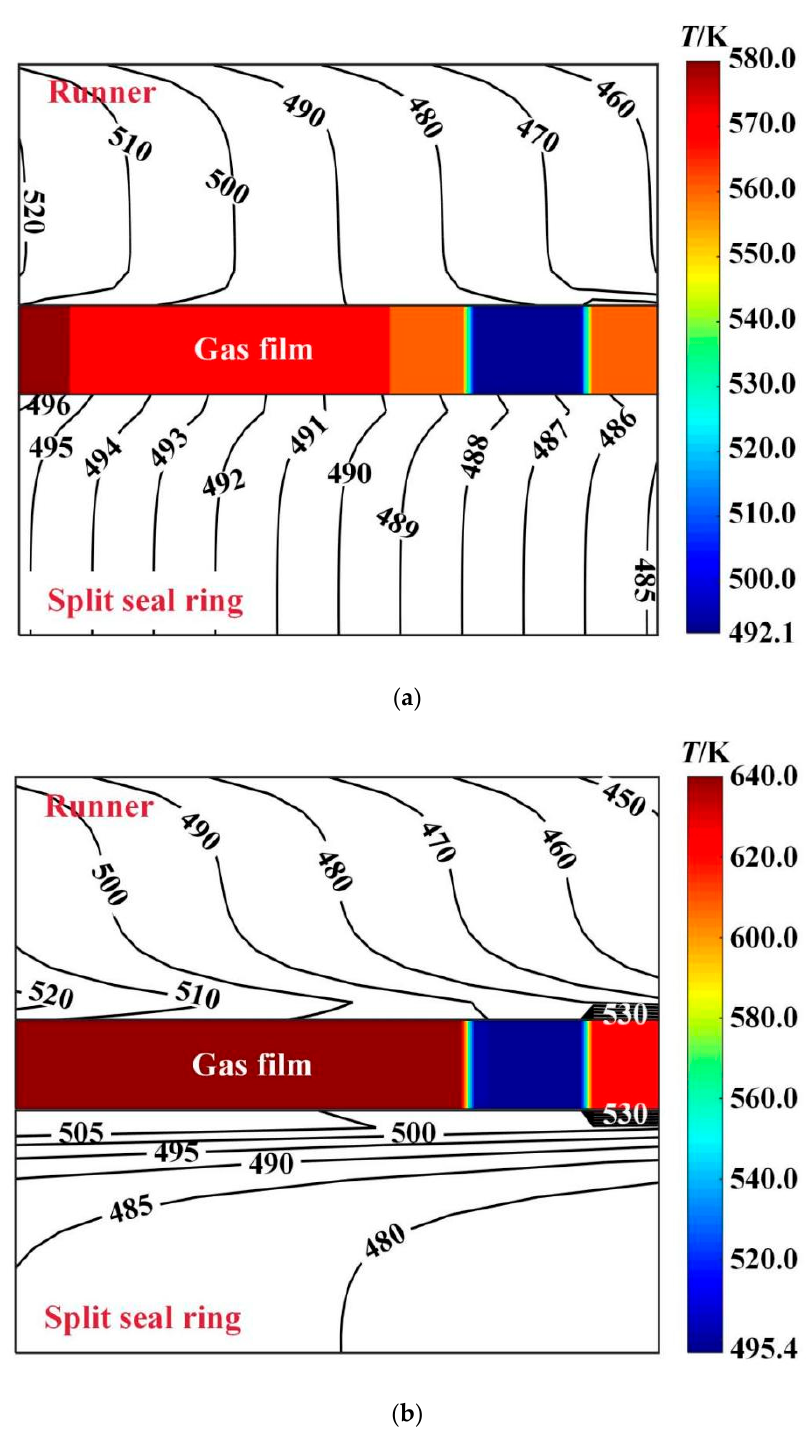
Figure 13. Influence of rotation speed on the maximum temperature of gas film. ( a ) β = 6 × 10 − 6 rad; ( b ) β = 0; ( p i = 0.2 MPa, ω = 3.0 × 10 4 r/min, T in = 580 K, T out = 380 K).